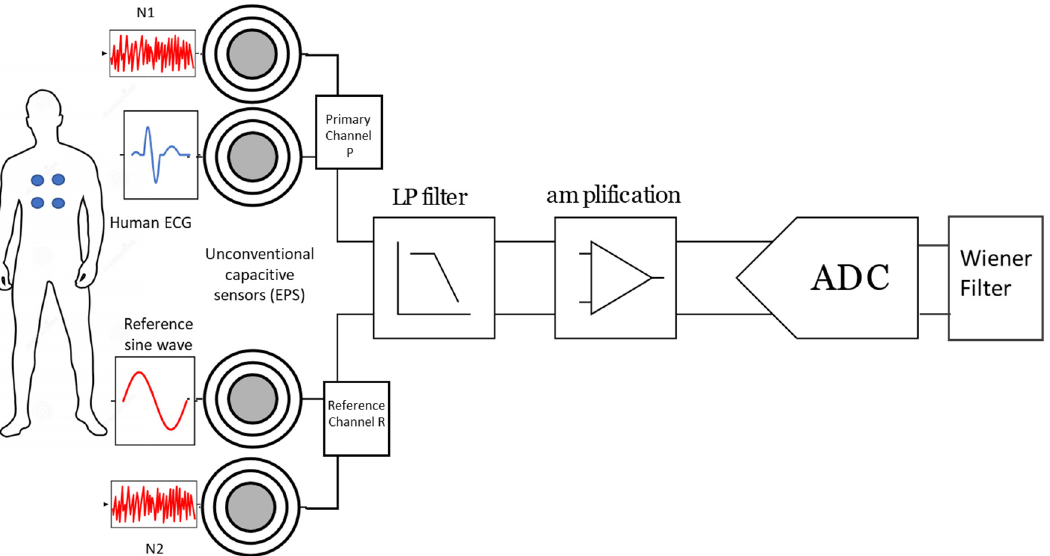
Figure 1. Experimental setup block diagram of the combined bio-signal denoising system configured for ECG detection.